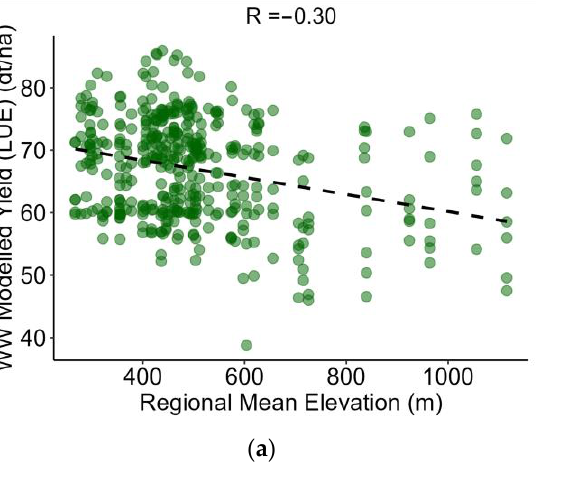
Figure 8. The scatter plots correlating the modelled yield and regional mean elevation for ( a ) WW and ( b ) OSR. The dashed line represents the regression line. Different colours of the points display different crop types (green for WW and orange for OSR). The correlation coefficient refers to R (see Equation (5)).